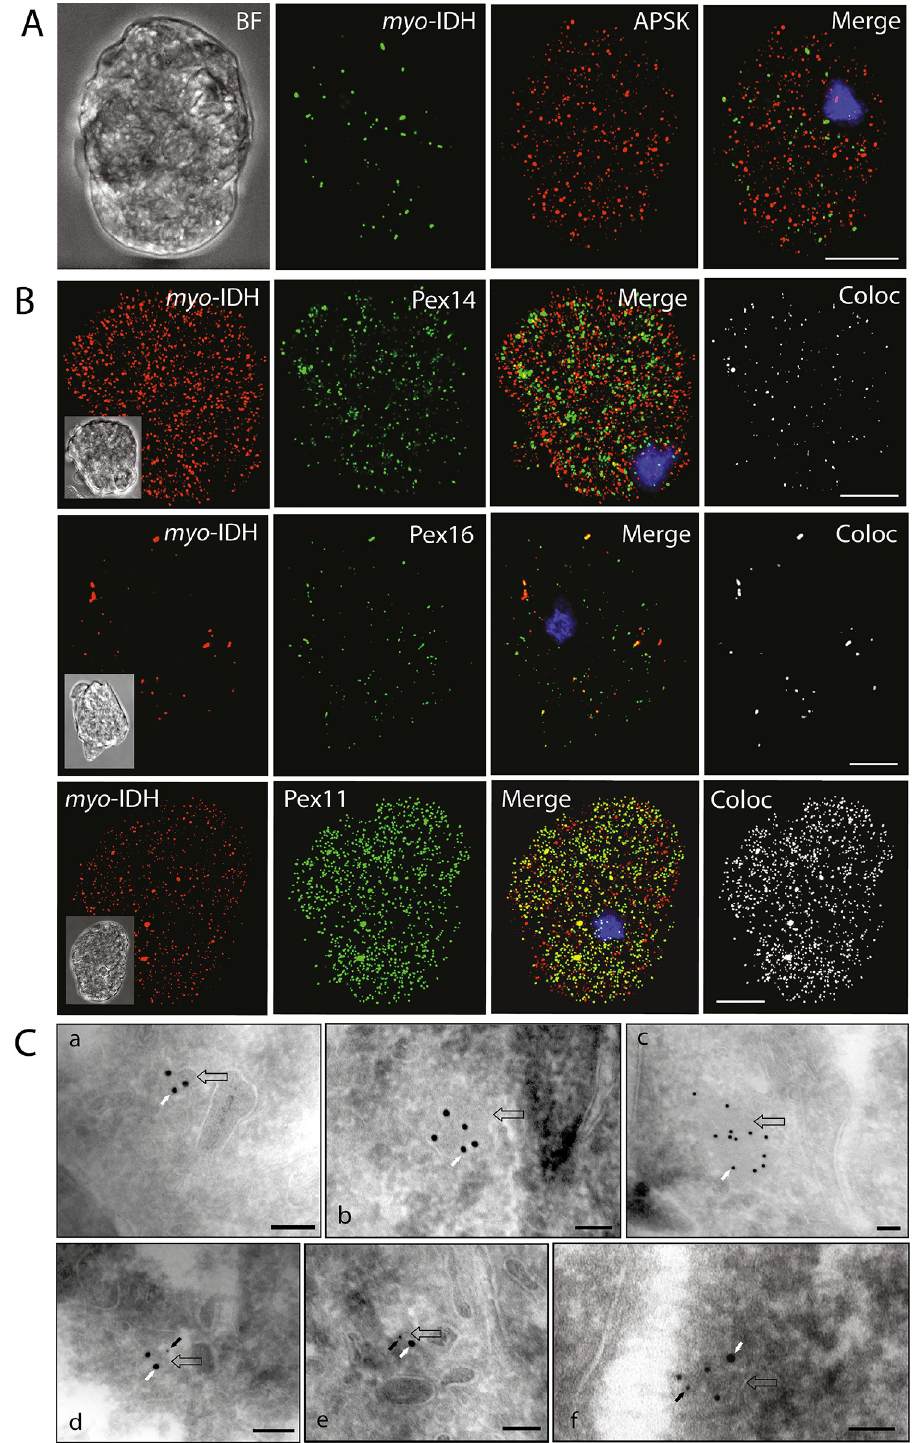
Fig 10. Localization of IDH in E . histolytica . A. Detection of myo -IDH (green)and APSK (mitosomal marker protein, red) in wild- type cells. Bar = 10 μ m. B. Detection of native myo -IDH (red) in cells expressing C-terminally His-tagged PEXs (green). Signal colocalization analysis (white) was performed by ImarisColoc software. Bar = 10 μ m. C. Immunoelectron microscopy. Myo -IDH was detected using a rabbit polyclonal anti- myo -IDH antibody and anti- rabbit IgG conjugated to 15 nm gold particles (white arrows, a-f), Pex16 was detected using a mouse monoclonal anti-